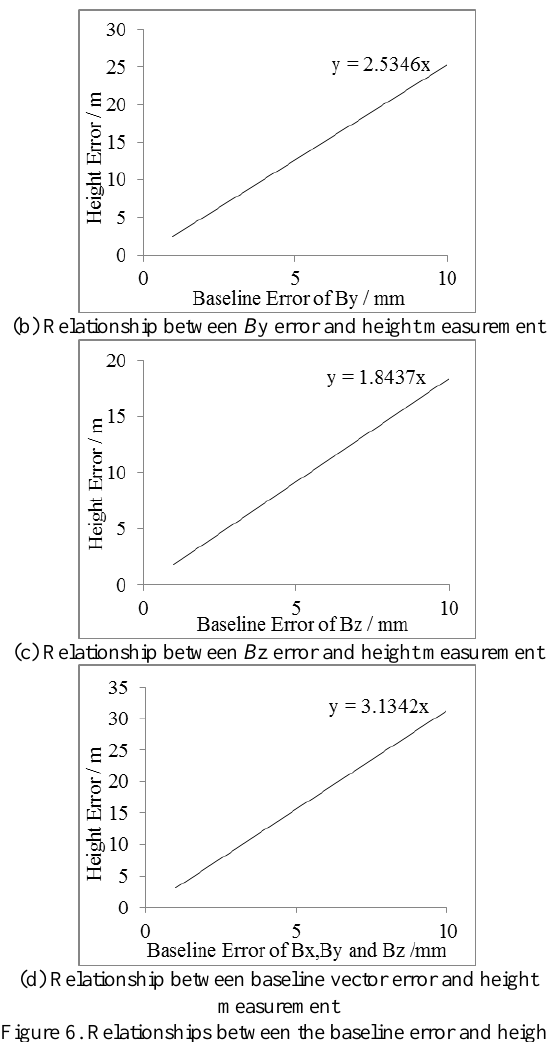
Figure 6. Relationships between the baseline error and height